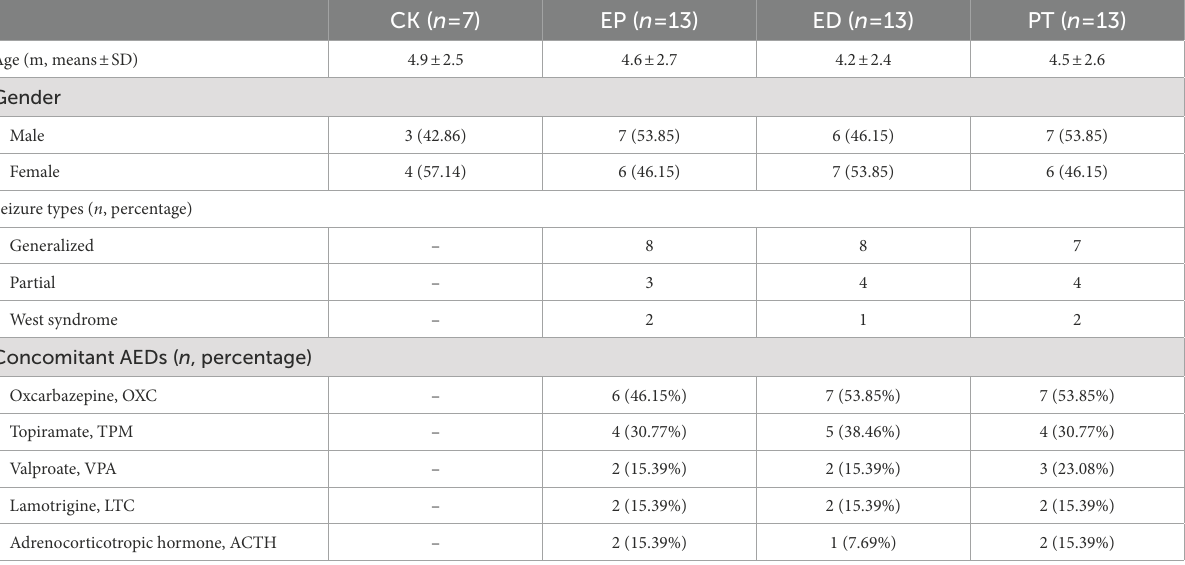
TABLE 1 Characteristics of the patients included in the